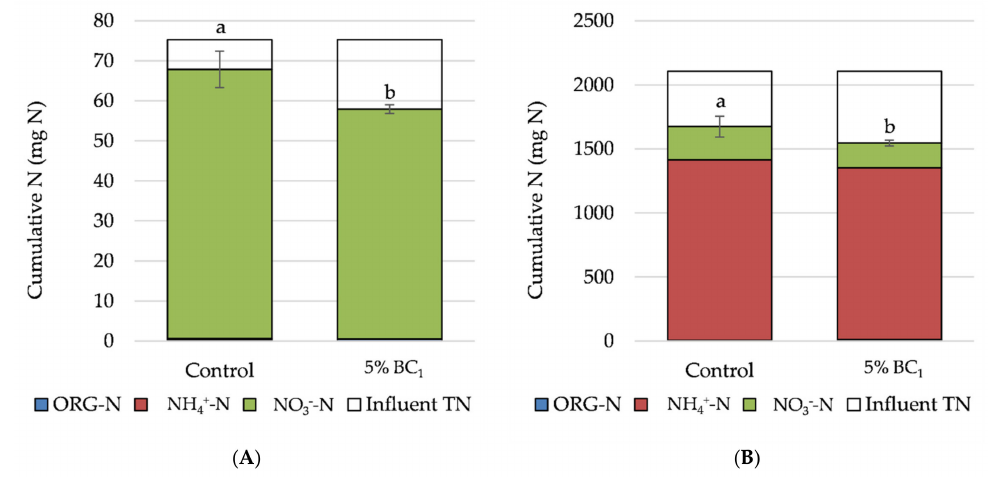
Figure 3. Cumulative mass of influent and e ffl uent N (mg N) for control and biochar columns receiving ( A ) NH 4 + -N low (treatment group 3), and ( B ) NH 4 + -N high (treatment group 4) application rates. Error bars represent standard deviation of e ffl uent TN between triplicate columns for treatment. Letters signify statistically significant di ff erence between treatments. Note: Entire bar (with no fill) represents total influent TN, where entire solid bar represents TN in e ffl uent. Individual N species in the e ffl uent are denoted based on color (blue, red, green).